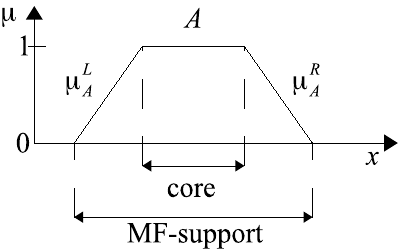
Figure 9. Meaning of the core and support of a trapezoidal T1MF.